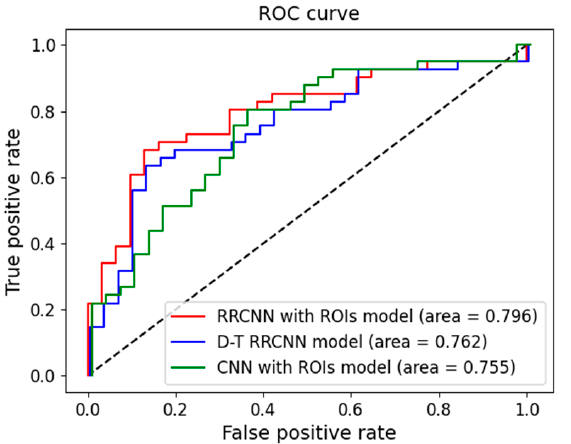
Figure 6. Receiver operating characteristic curves for the proposed three models: Recurrent Residual Convolutional Neural Network (RRCNN) with Regions of Interest (ROIs), Detection-Transfer (D-T) RRCNN, and 2D Convolutional Neural Network (CNN) with ROIs